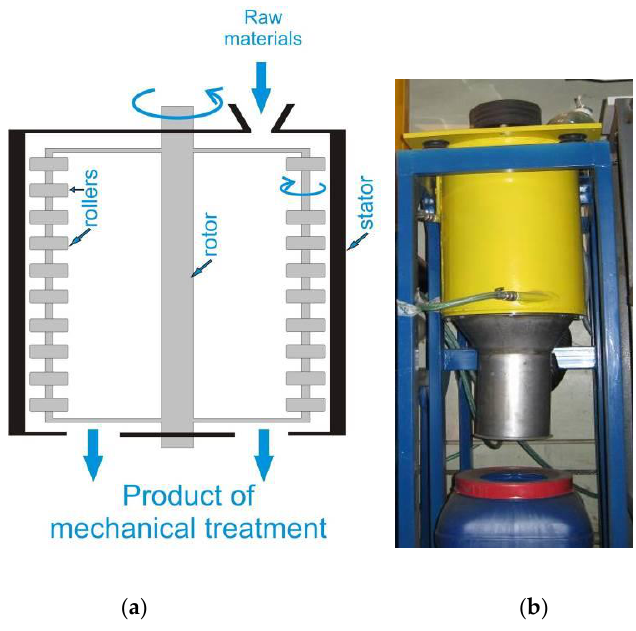
Figure 9. A centrifugal roller mill: ( a ) schematic; ( b ) an example of the real-world grinder designed by the engineering department of the Institute of Solid State Chemistry and Mechanochemistry, SB RAS.